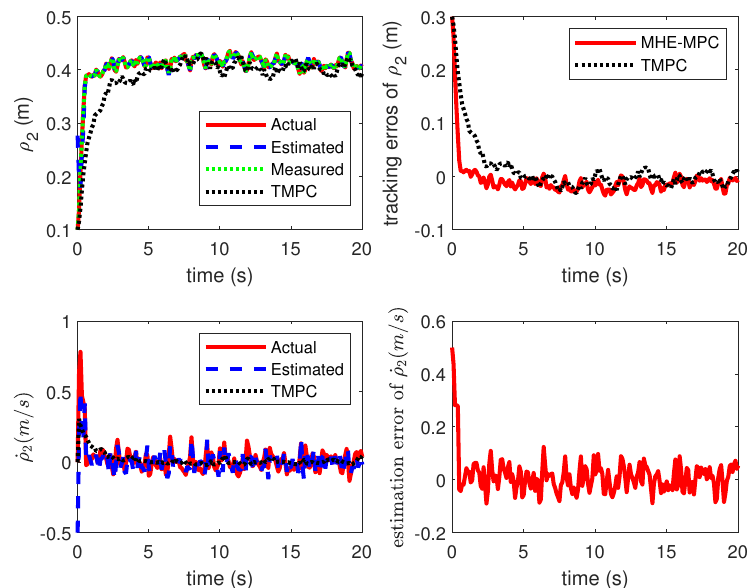
Figure 9. Case 2: state variables ρ 2 , ˙ ρ 2 and their tracking/estimation errors.